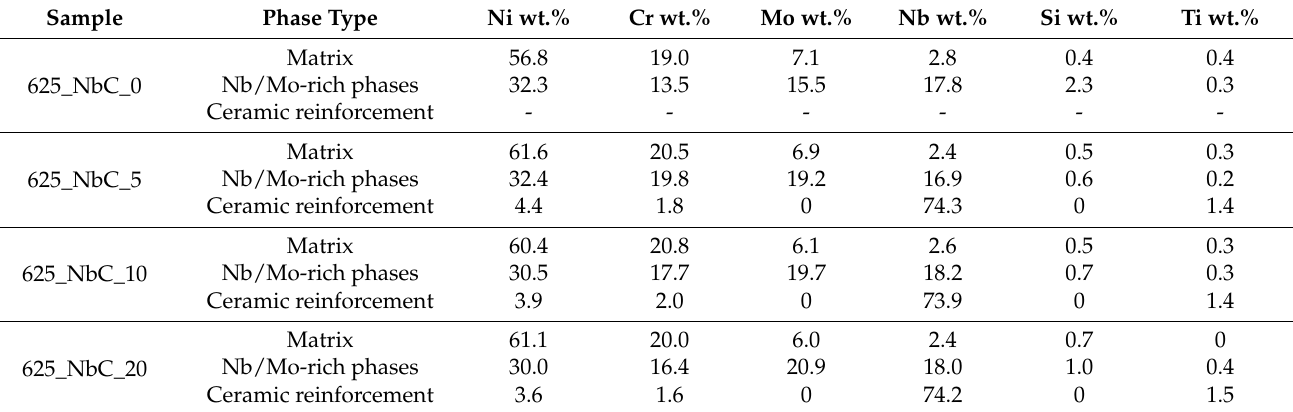
Table 5. EDS qualitative analysis of Inconel 625-NbC